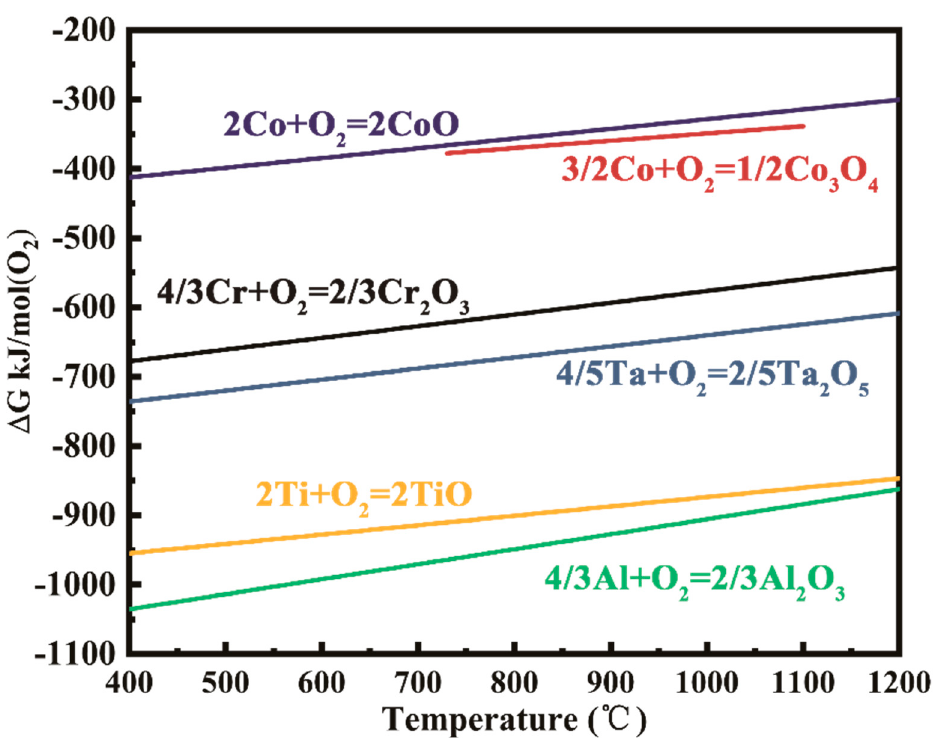
Figure 11. The relationship between the formation of Gibbs free energy of various oxides materials and temperature.